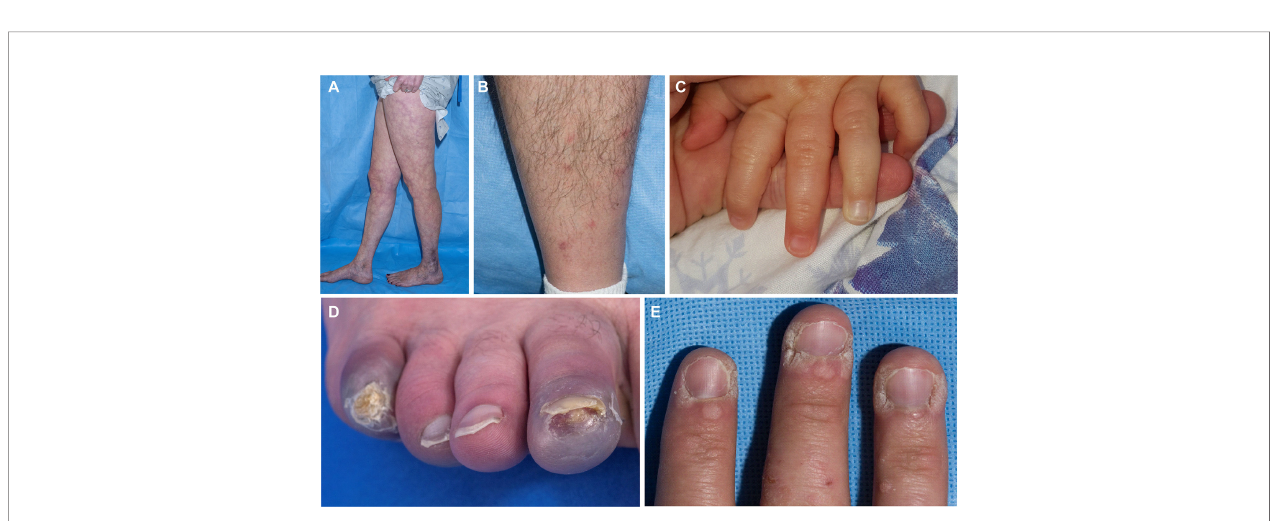
FIGURE 2 | The cutaneous manifestations of DADA2. (A) Livedo racemosa on the legs of a 38-year-old. (B) Nodules that when biopsied revealed medium vessel vasculitis in a 58-year-old. (Cutaneous polyarteritis nodosa [PAN]). (C) Raynaud ’ s phenomenon in a 13-month-old. (D) Acral cyanosis and cutaneous ulcer in a 27- year-old. (E) Verruca vulgaris in a 29-year-old.